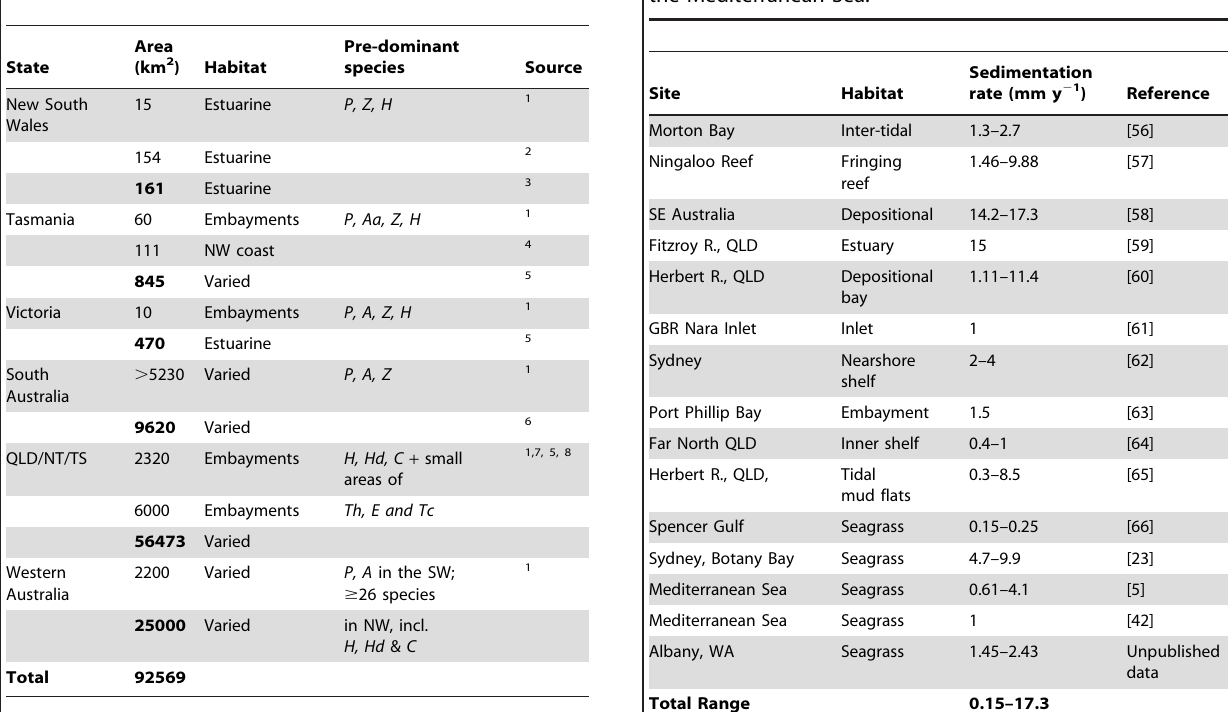
Table 3. Published sediment accumulation rates (by depth) for Australian coastal marine ecosystems and P. oceanica from the Mediterranean